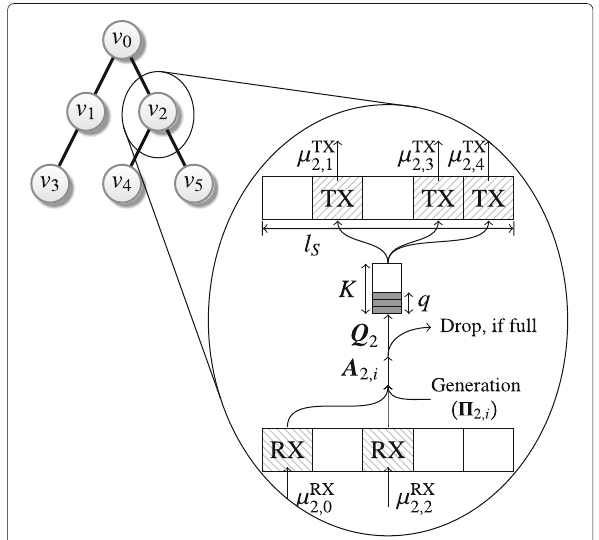
Fig. 1 Illustration of the proposed model annotated with the notation